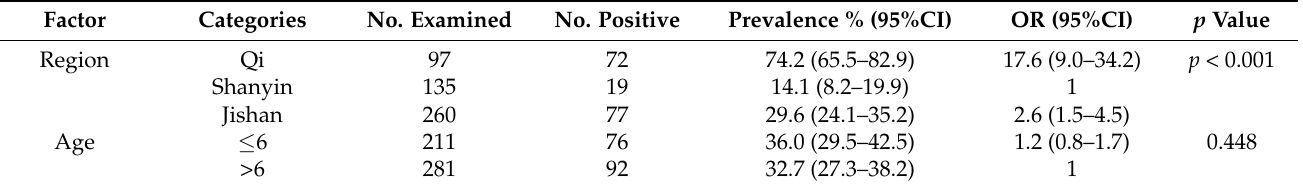
Table 1. Factors associated with prevalence of Enterocytozoon bieneusi in sheep in Shanxi